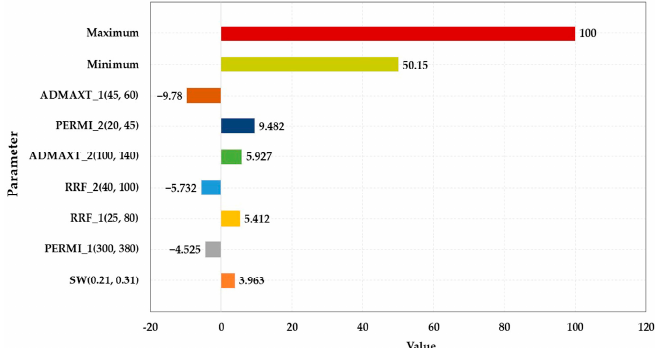
Figure 10. Parameter sensitivity analysis of the water cut of the LPL.